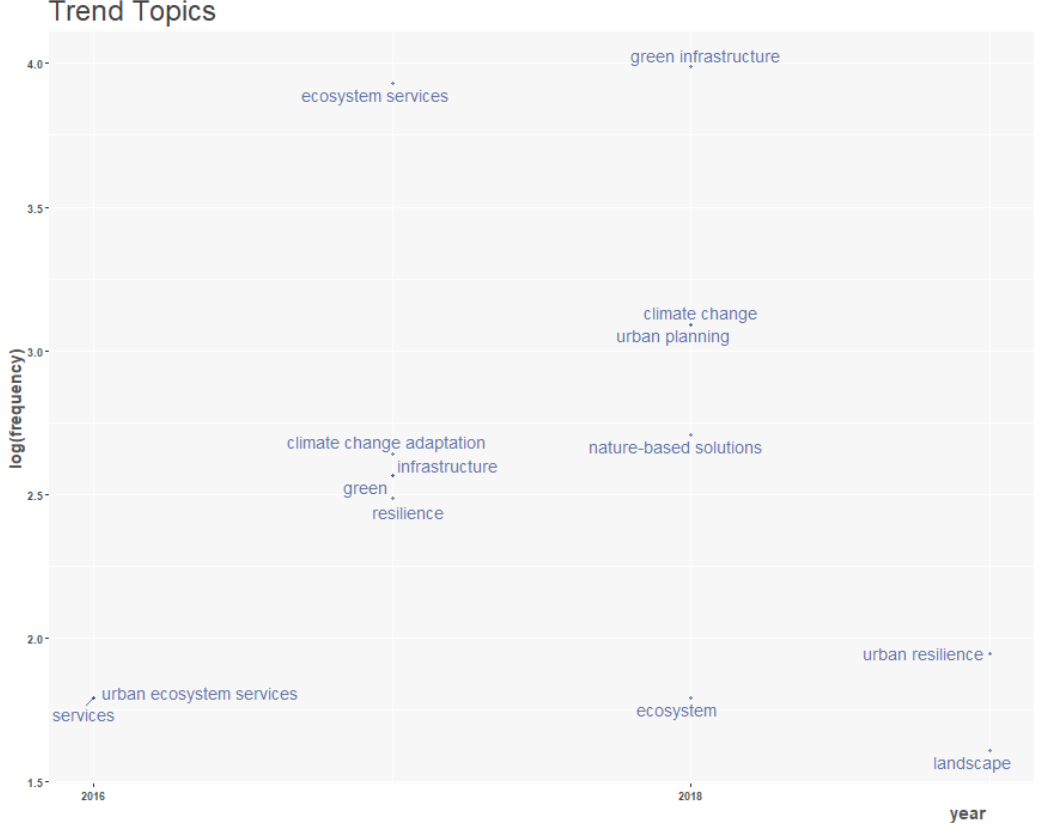
Figure 11. Trend topics by Author Keywords. Source: Biblioshiny. Own